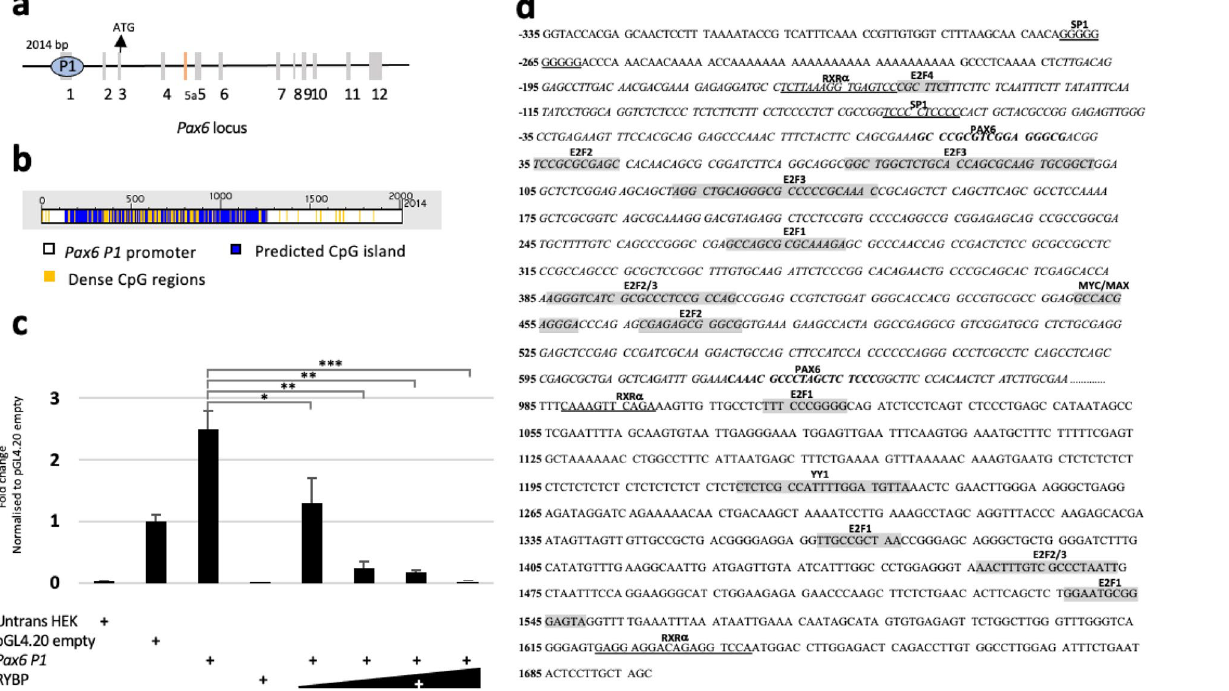
Figure 6. RYBP represses Pax6 gene expression through the Pax6 P1 promoter. ( a ) The Pax6 genomic locus showing the position of the 2014 bp P1 promoter used in this study. ( b ) CpG island prediction at the Pax6 P1 promoter was performed in DBCAT (http:// dbcat. cgm. ntu. edu. tw). The predicted CpG island is represented in blue and the denser CpG regions are displayed in yellow. ( c ) Luciferase assays were performed in HEK293 cells transiently transfected with mouse Pax6 P1 promoter reporter (pGL4.20 Pax6 P1 ) or with empty vector (pGL4.20) and RYBP expression plasmid in increasing dosages (1 µg, 5 µg, 10 µg and 20 µg). Values are expressed as fold changes of luciferase activity normalized to the empty vector. The presented values are averages of three independent experiments. Means are standard deviation ± SD. Values of p < 0.05 were accepted as significant (* p < 0.05; ** p < 0.01; *** p < 0.001, n = 3). Statistical method: T test type 3. ( d ) Pax6 P1 promoter highlighting the position of key transcription factor binding sites and CpG islands. CpG island is represented in italics. The transcription factor binding sites of RYBP interacting proteins are highlighted in grey. PAX6 self-binding sites are represented in bold, RXRα and SP1 binding sites are underlined. Untrans HEK Untransfected HEK293 cells, SP1 Trans-acting transcription factor 1, E2F E2 transcription factor, MYC / MAX Myelocytomatosis oncogene/MYC associated factor X, YY1 Yin-yang-1 transcription